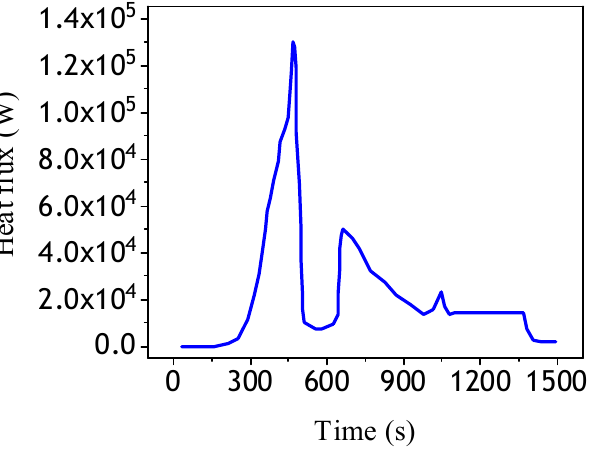
Figure 6. Heat flow of actual flight mission.